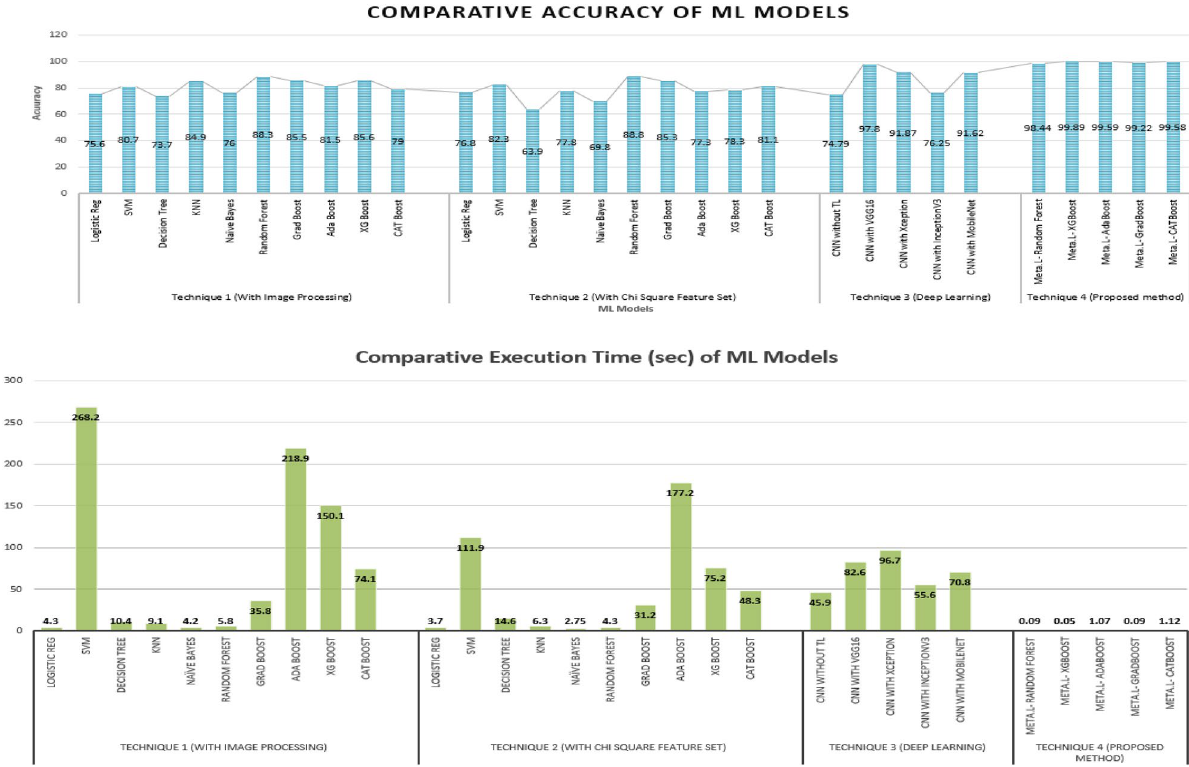
Figure 5. Comparative analysis of ( a ) accuracy and ( b ) execution time for ML models using different